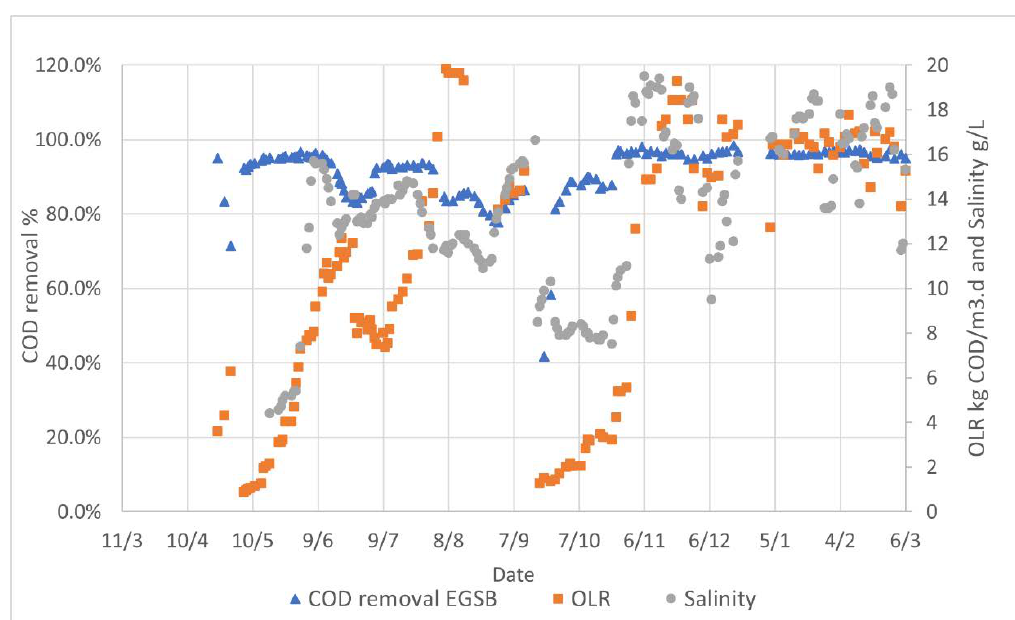
Figure 9. Relation of COD removal with salinity and organic loading rate.